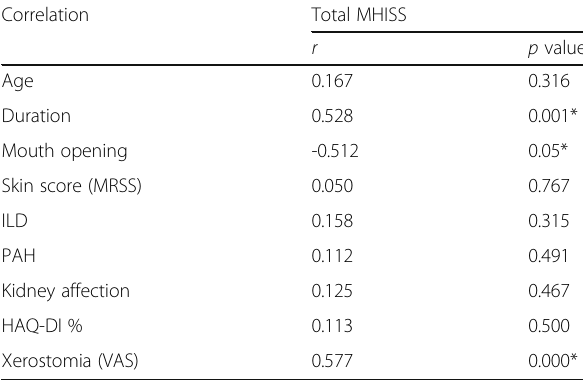
Table 4 External validity of the Arabic version of MHISS